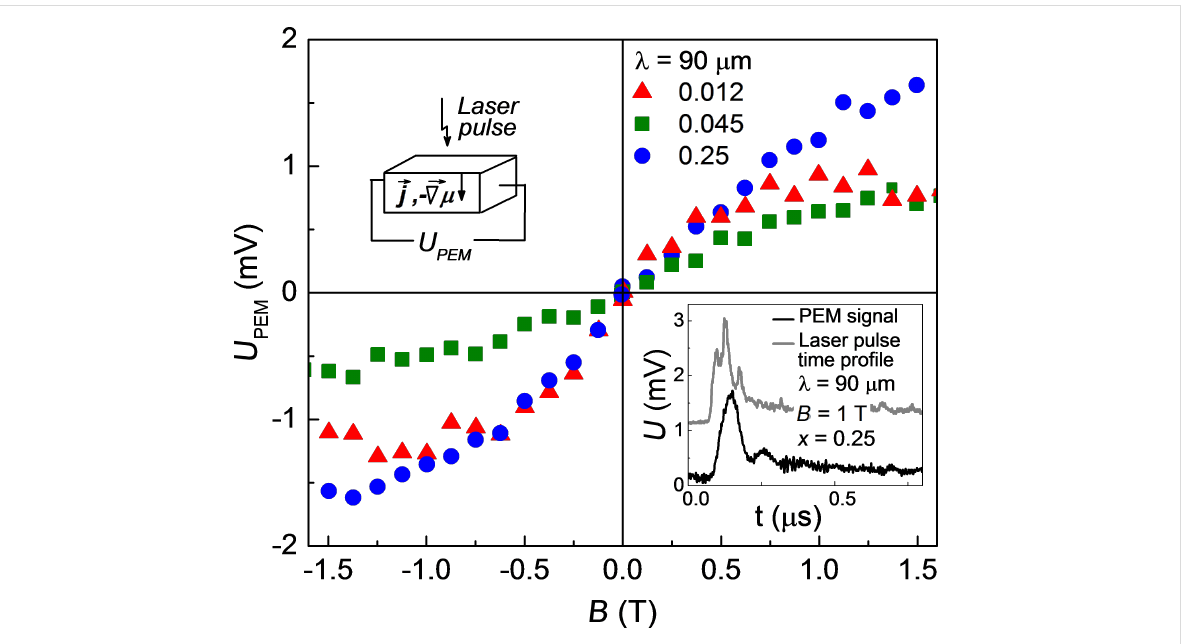
Figure 1: Dependence of the PEM effect amplitude on the magnetic field B applied for (Cd 1 − x Zn x ) 3 As 2 samples for alloy compositions x = 0.012, 0.045 and 0.25. The laser wavelength was λ = 90 μ m and T = 4.2 K. The experimental geometry is shown in the upper left inset. Typical shape of the laser pulse and PEM response are shown in the lower right inset.